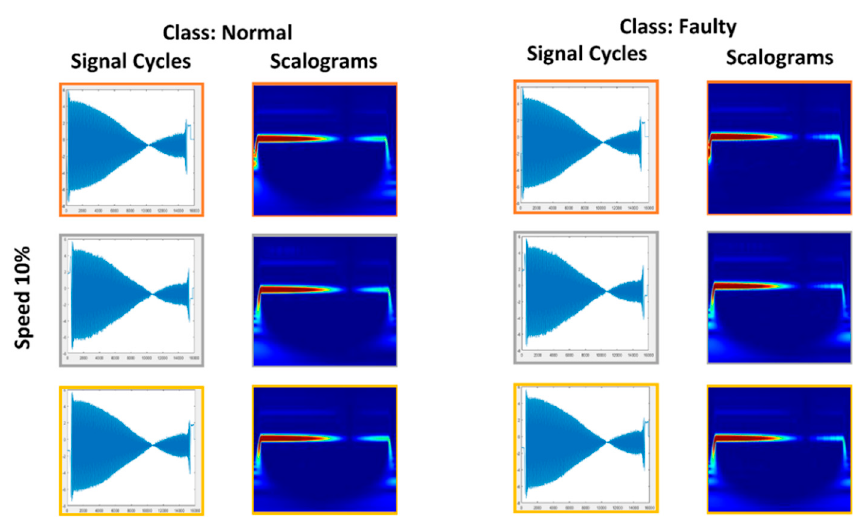
Figure 11. Example of the de-noised signal cycle after DWT implementation.